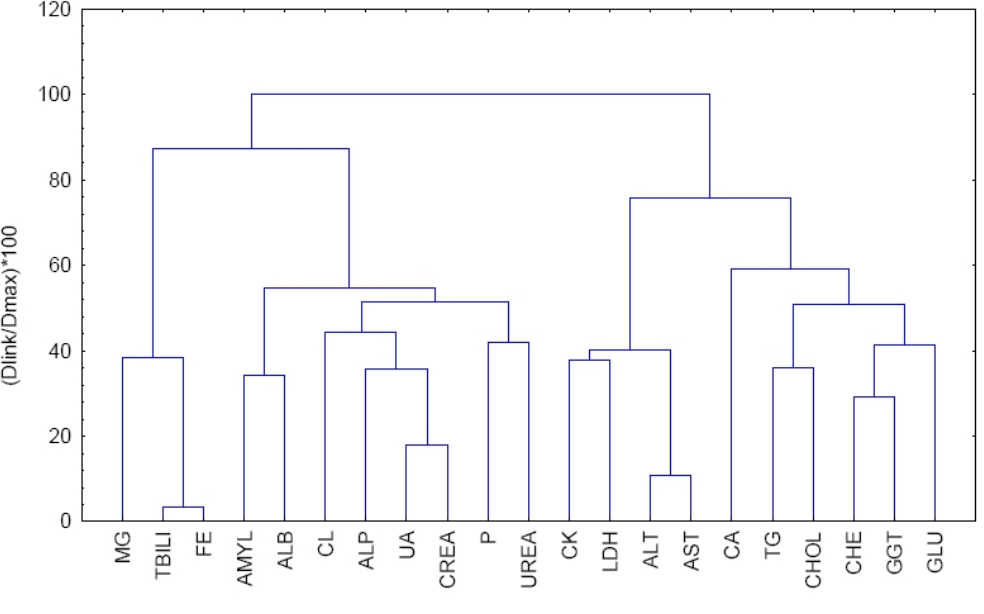
Fig. 4 Hierarchical dendrogram for 21 clinical parameters of “young” healthy